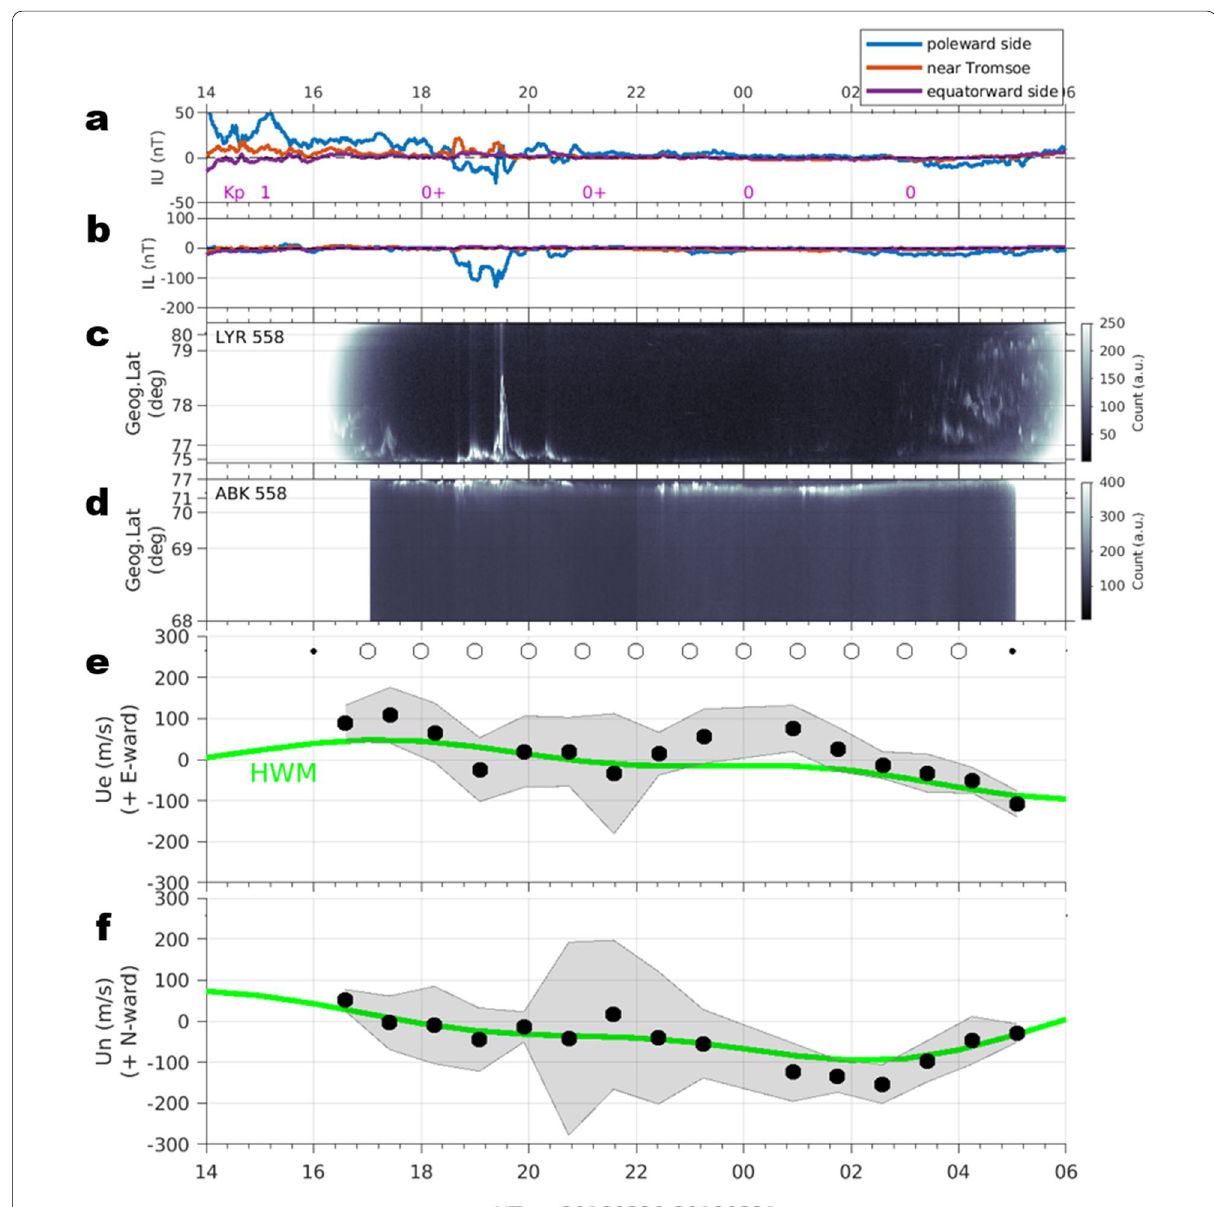
Fig. 1 Measurements on 2018 February 20–21 of a , b IU and IL indices made of IMAGE magnetometers segmented into three areas (poleward (blue; 74.50–78.92°N), near (orange; 68.02–71.09°N) and equatorward (purple; 58.26–66.90°N) side of Tromsø (69.58°N)), c , d keograms made using the all‑sky camera (558 nm) at Longyearbyen and Abisko, respectively, and e , f zonal and meridional components (positive eastward and northward, respectively) of the thermospheric wind velocity measured with the FPI at Tromsø (630 nm). Post‑integration of 20 FPI fringe images, corresponding to a 50 min time resolution of the wind vector (black solid circles), was applied to the original images taken every 2.5 min. The error bars for each wind component ( 1σ) are shown in shading. HWM winds at 250‑km altitude are overlaid (green curves). The Kp index every 3 h is marked in ( a ±